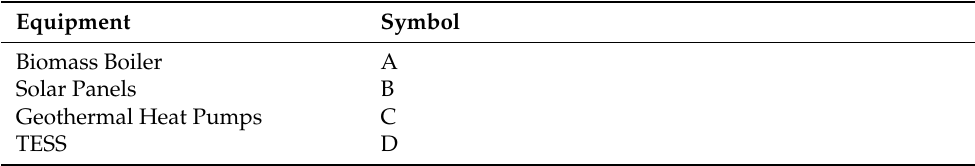
Table 4. The symbols used to describe the technologies included in the final superstructure